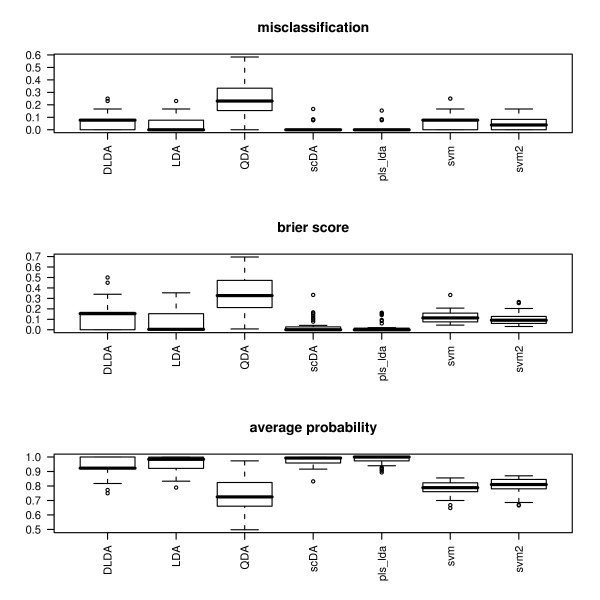
Classification accuracy with Khan's SRBCT data. Boxplots representing the misclassification rate (top), the Brier score (middle), and the average probability of correct classification (bottom) for Khan's SRBCT data, using seven classifiers: diagonal linear discriminant analysis, linear discriminant analysis, quadratic discriminant analysis, shrunken centroids discriminant analysis (PAM), PLS followed by linear discriminant analysis, SVM without tuning, and SVM with tuning.